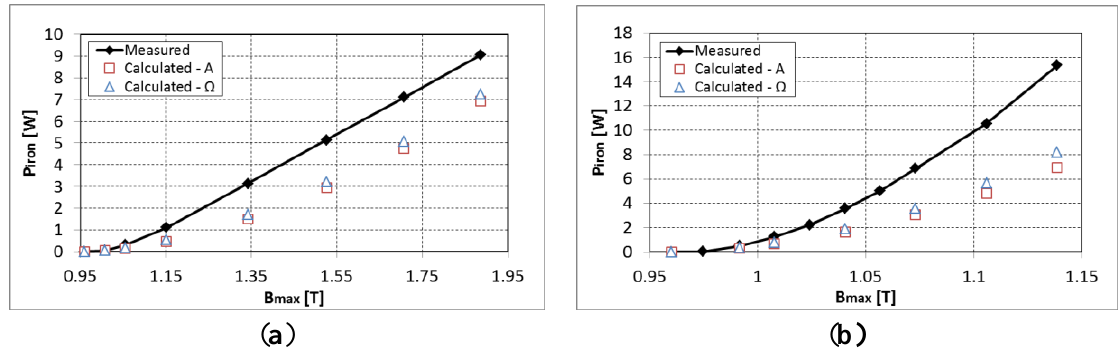
Figure 5. Calculation and measurement of the iron losses in the experimental device with an offset of 0.96 T at ( a ) 50 Hz and ( b ) 600